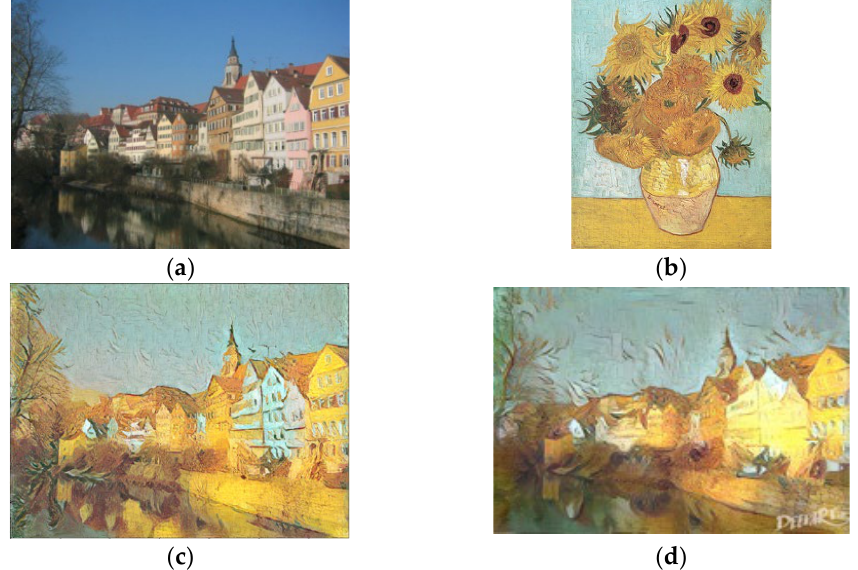
Figure 18. Comparison with Gatys et al.’s method. ( a ) Content image. ( b ) Target image. ( c ) Our results. ( d ) The result of Gatys et al.’s method, with the content features on layer conv4_2 and the